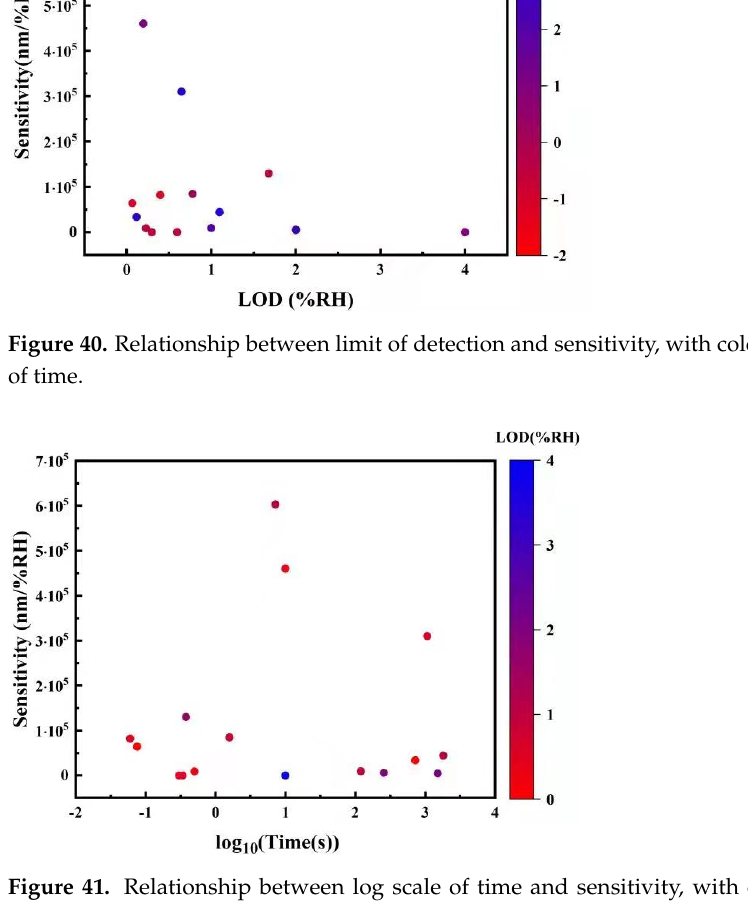
Figure 42. Relationship between log scale of time and limit of detection, with color representing sensitivity.